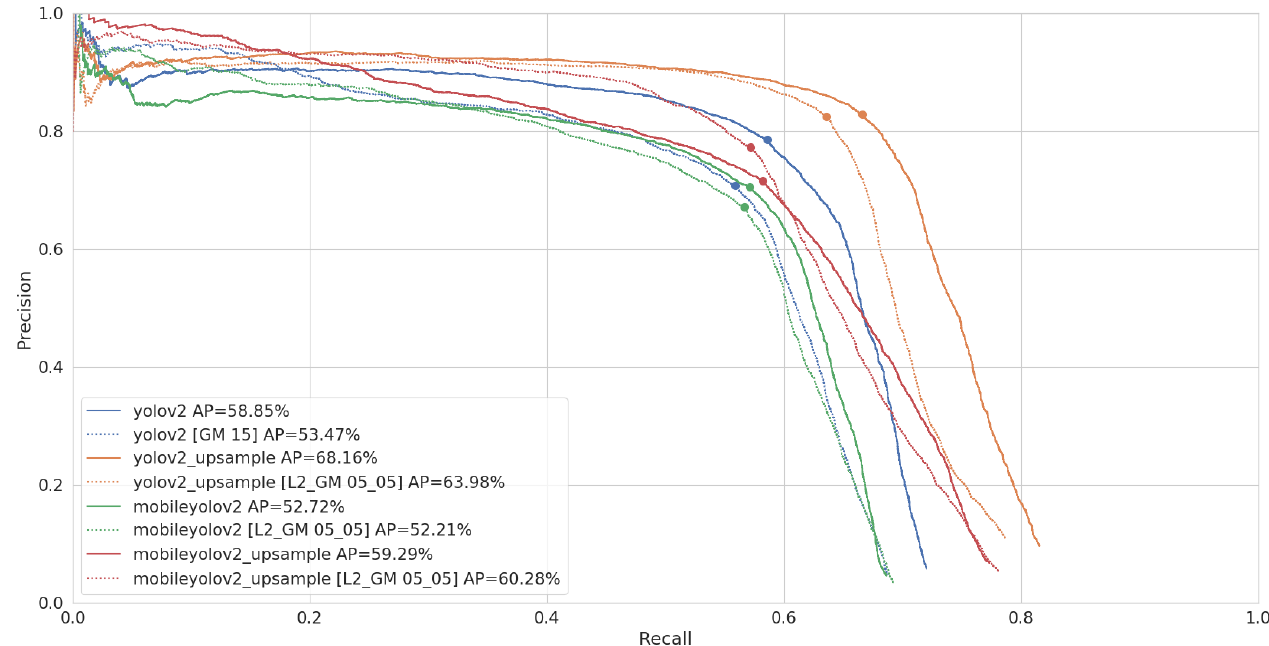
Figure 14. PR curve and AP of our models on the LWIR test set. The best F1 point is marked for each curve, which is used as a confidence threshold when performing the timing